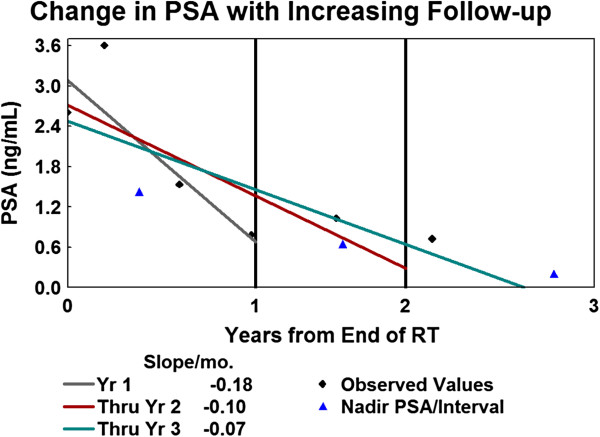
Calculation of slope and PSA nadir for a sample patient for 3 time durations, 1, 2 and 3 years post-RT for a patient treated with SBRT.